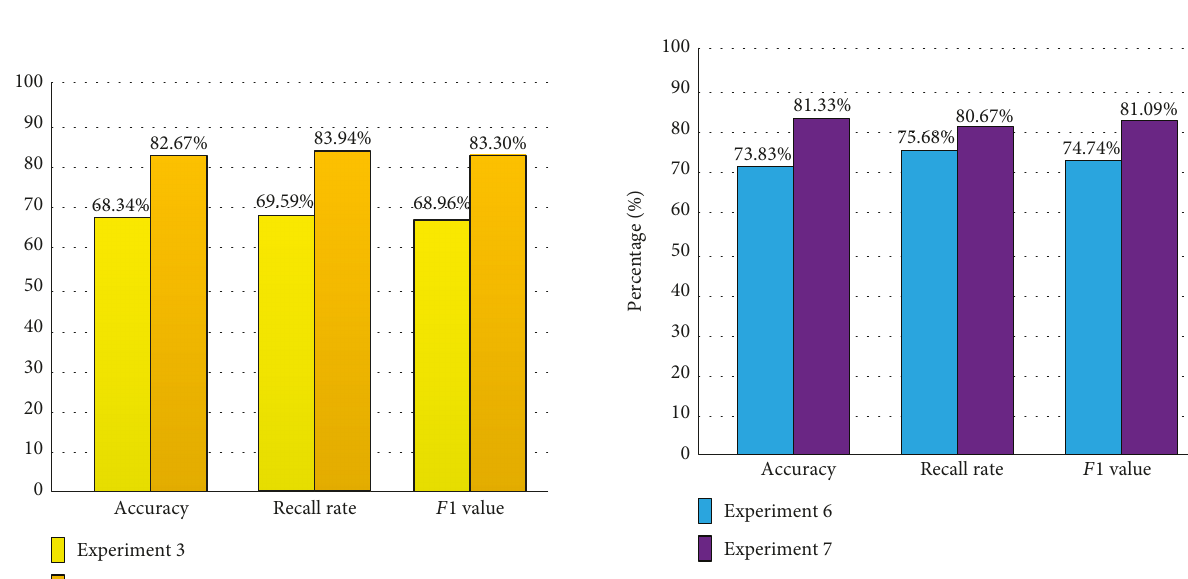
Figure 7: Comparison of Experiment 6 and Experiment